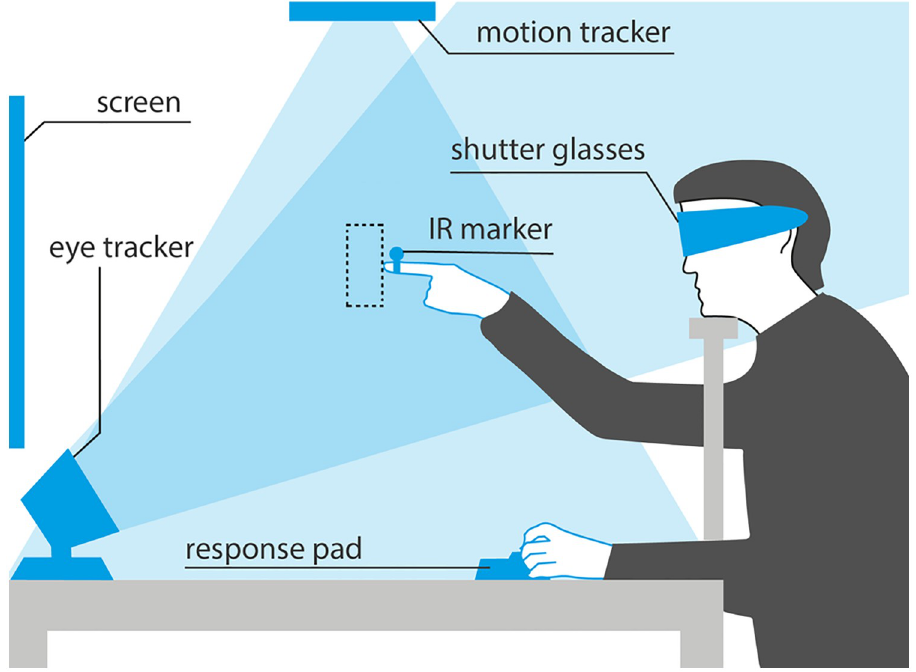
Fig 1. Experimental setup. Schematic representation of the experimental setup (not drawn to scale, forehead rest not shown); adapted from [19, 43, 44].